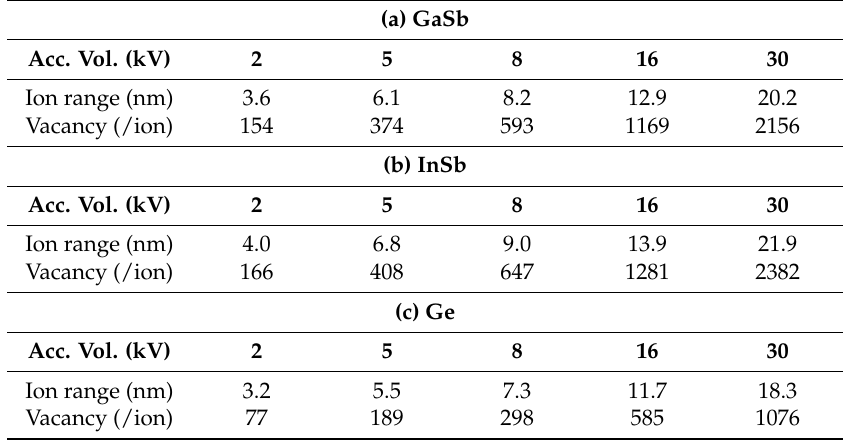
Table 1. Projected range and vacancy per ion calculated by SRIM simulations in ( a ) GaSb, ( b ) InSb, and ( c )